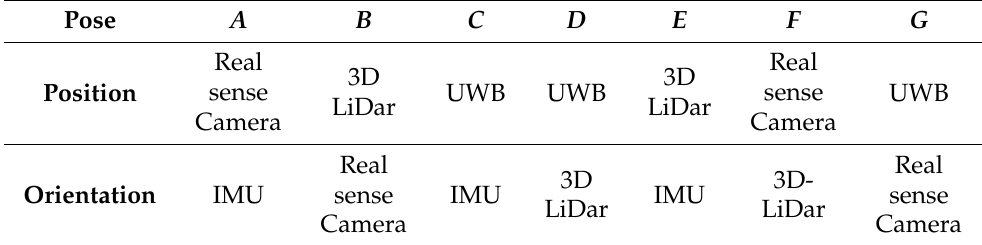
Table 1. Combination of sensor information used to construct the nodes of the proposed first layer Pose A B C D E F G Real Real 3D 3D Position sense sense UWB UWB UWB LiDar LiDar Camera Camera Real Real 3D 3D- Orientation IMU sense sense IMU IMU LiDar LiDar Camera